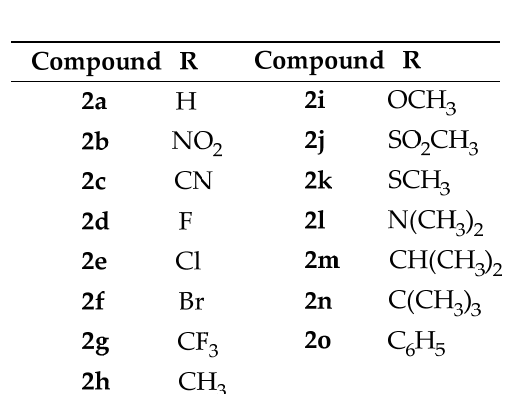
Table 1. The percentage inhibition values of compounds 2a – o and sitagliptin for DPP-4.